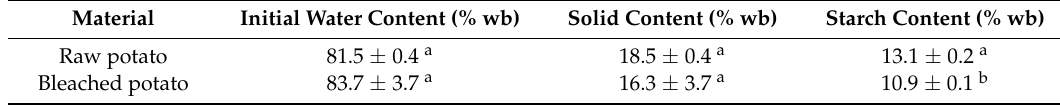
Table 1. Initial water content, solid content and starch content of potato before and after blanching *.